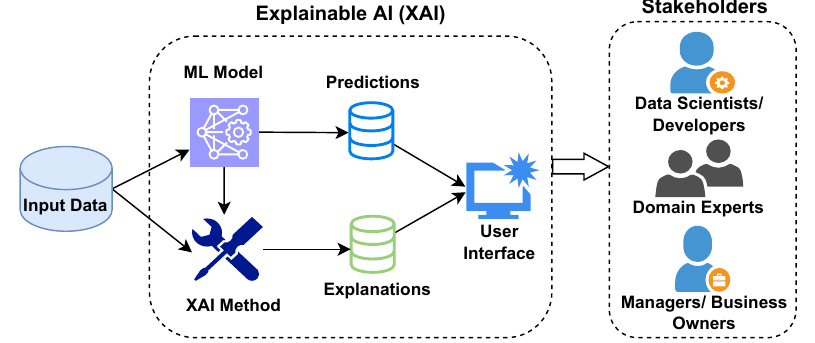
Figure 3. Explainable AI (XAI) and possible